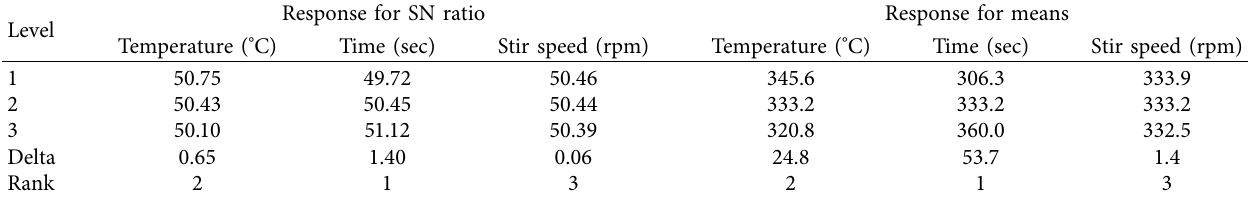
Table 5: Compressive strength response